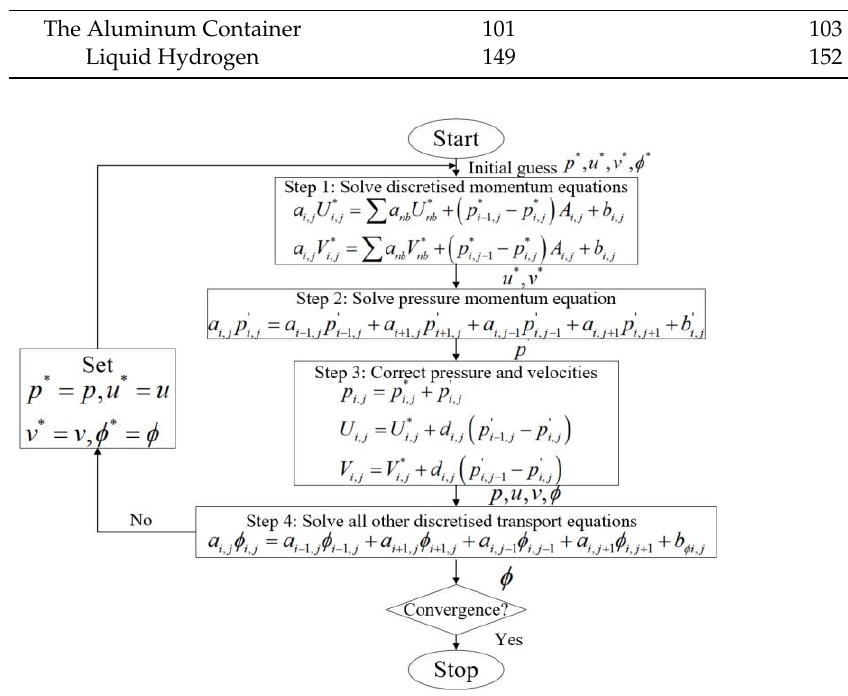
Figure 4. The algorithm of SIMPLE.